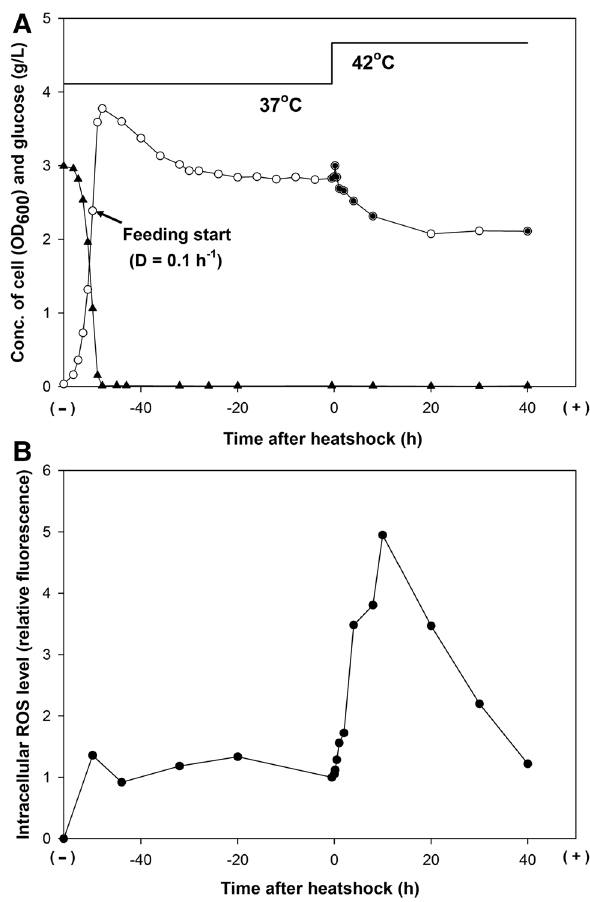
Figure 1. Chemostat culture of E. coli BL21(DE3) under heatshock stress. ( A ) Time profiles of the cell density (open circle) and glucose concentration in the culture media (filled triangle). The filled circles indicate the sampling points for transcriptome and proteome analyses, which were done 30 min before the temperature increase (from 37 to 42 °C) and after 2 min, 10 min, 30 min, 1 h, 2 h, 4 h, 8 h, and 40 h. ( B ) Time profiles of the intracellular reactive oxygen species (ROS)